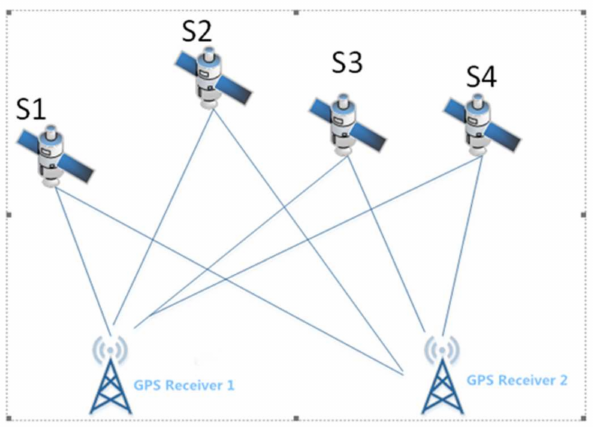
Figure 3. GPS relative positioning